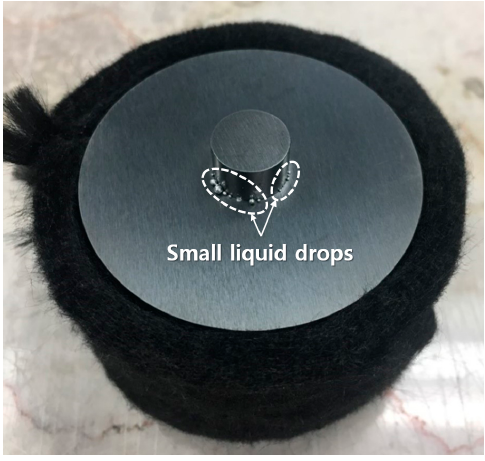
SUS316L bulk and Al-50 vol.% SUS316L composite.